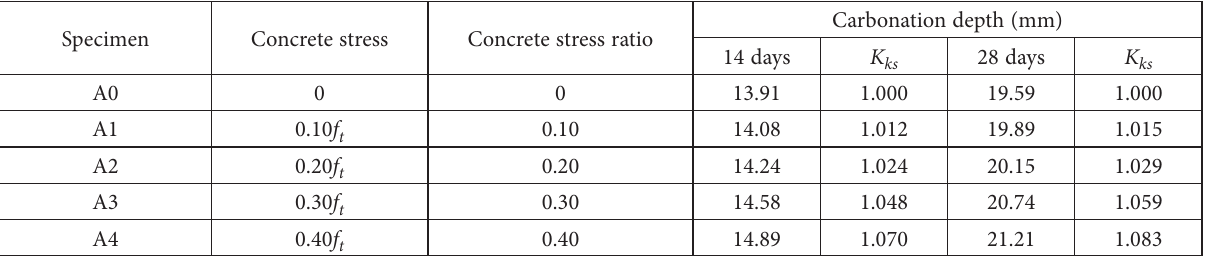
Table 11. Carbonation depths of specimens under different concrete stress conditions (data from Wang, 2018)